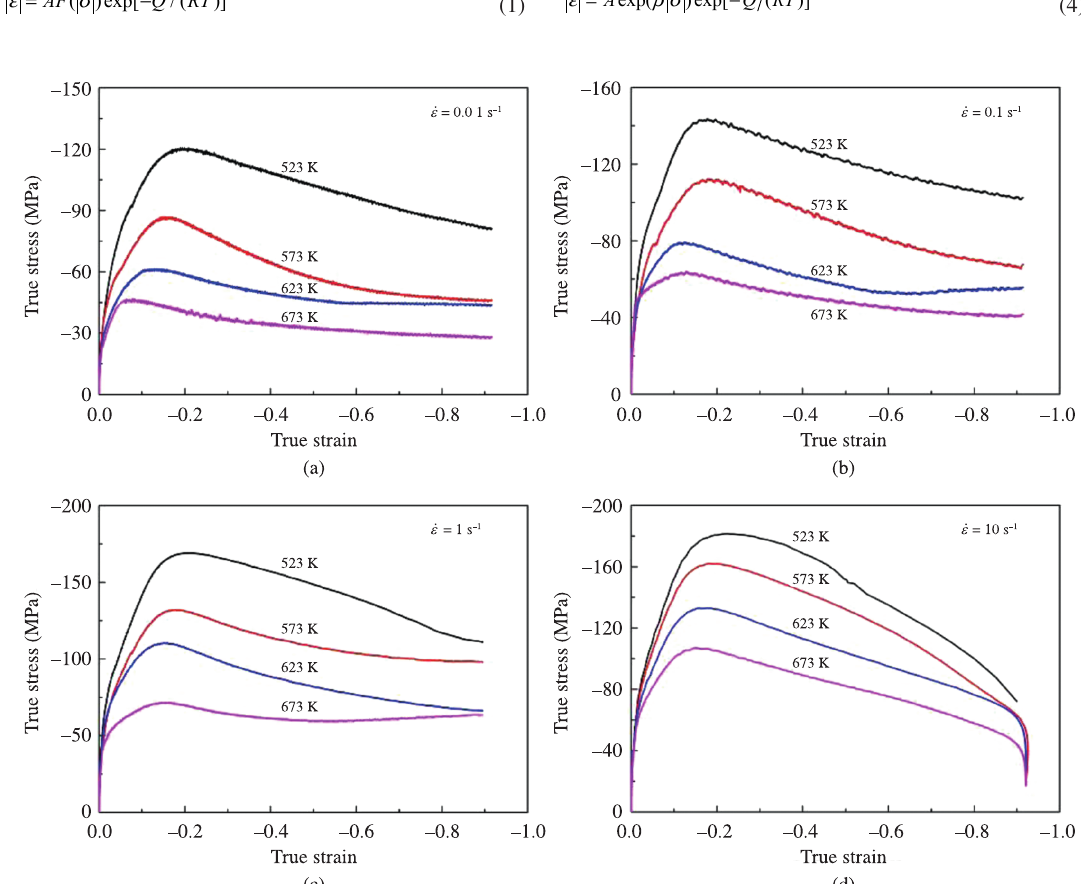
Figure 1. True strain-stress curves for as-cast AZ80 magnesium alloy under the different deformation temperatures with strain rates of: (a) 0.01 s –1 ; (b) 0.1 s –1 ; (c) 1 s –1 ; (d) 10 s –1